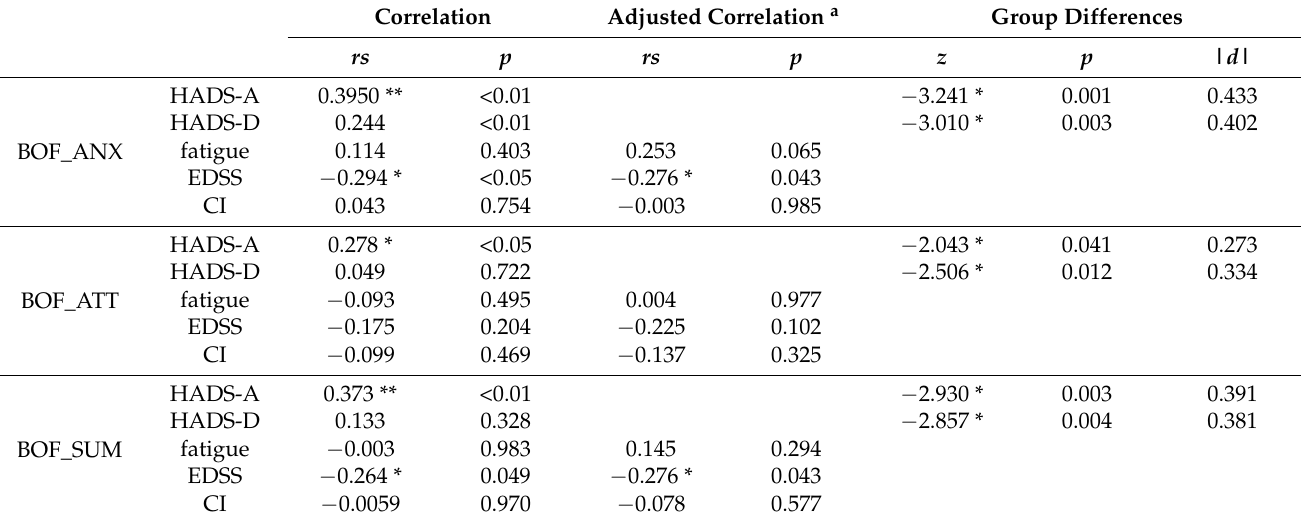
Table 5. Spearman bivariate correlation and partial correlation of the HADS (N =